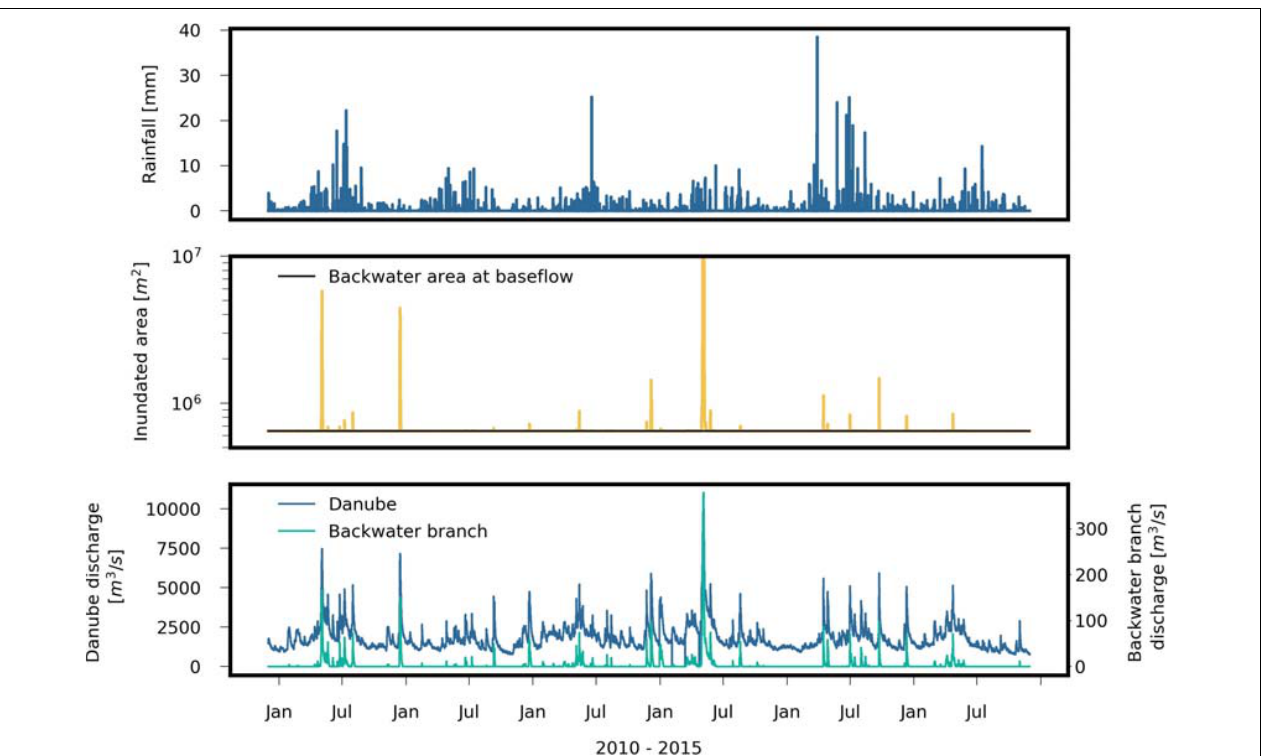
FIGURE 3 | Observed hourly rainfall and Danube discharge, and, simulated hourly discharge of the backwater channel and inundated area by means of regression ( Supplementary Table 2 ) during the investigation